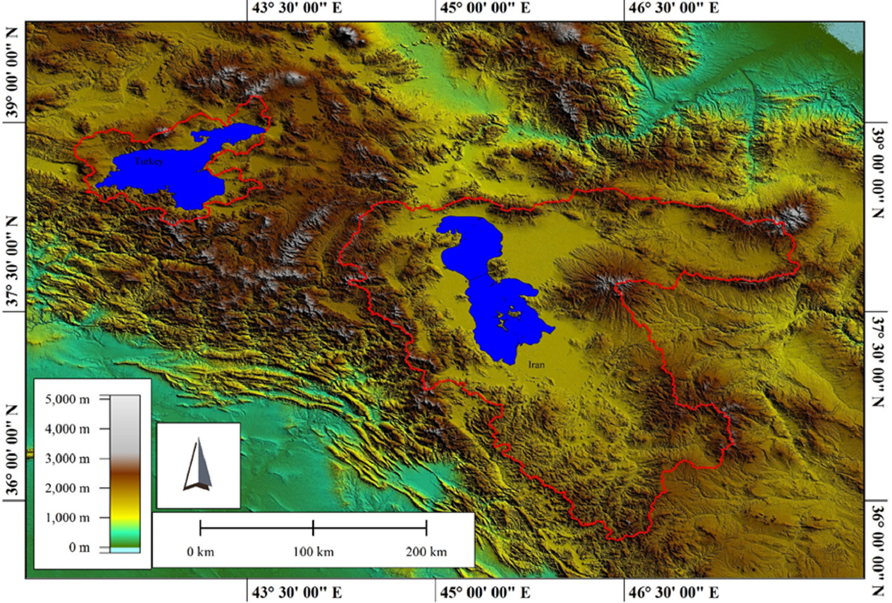
Figure 1. Location of LU in Iran and LV in Turkey and their basins.